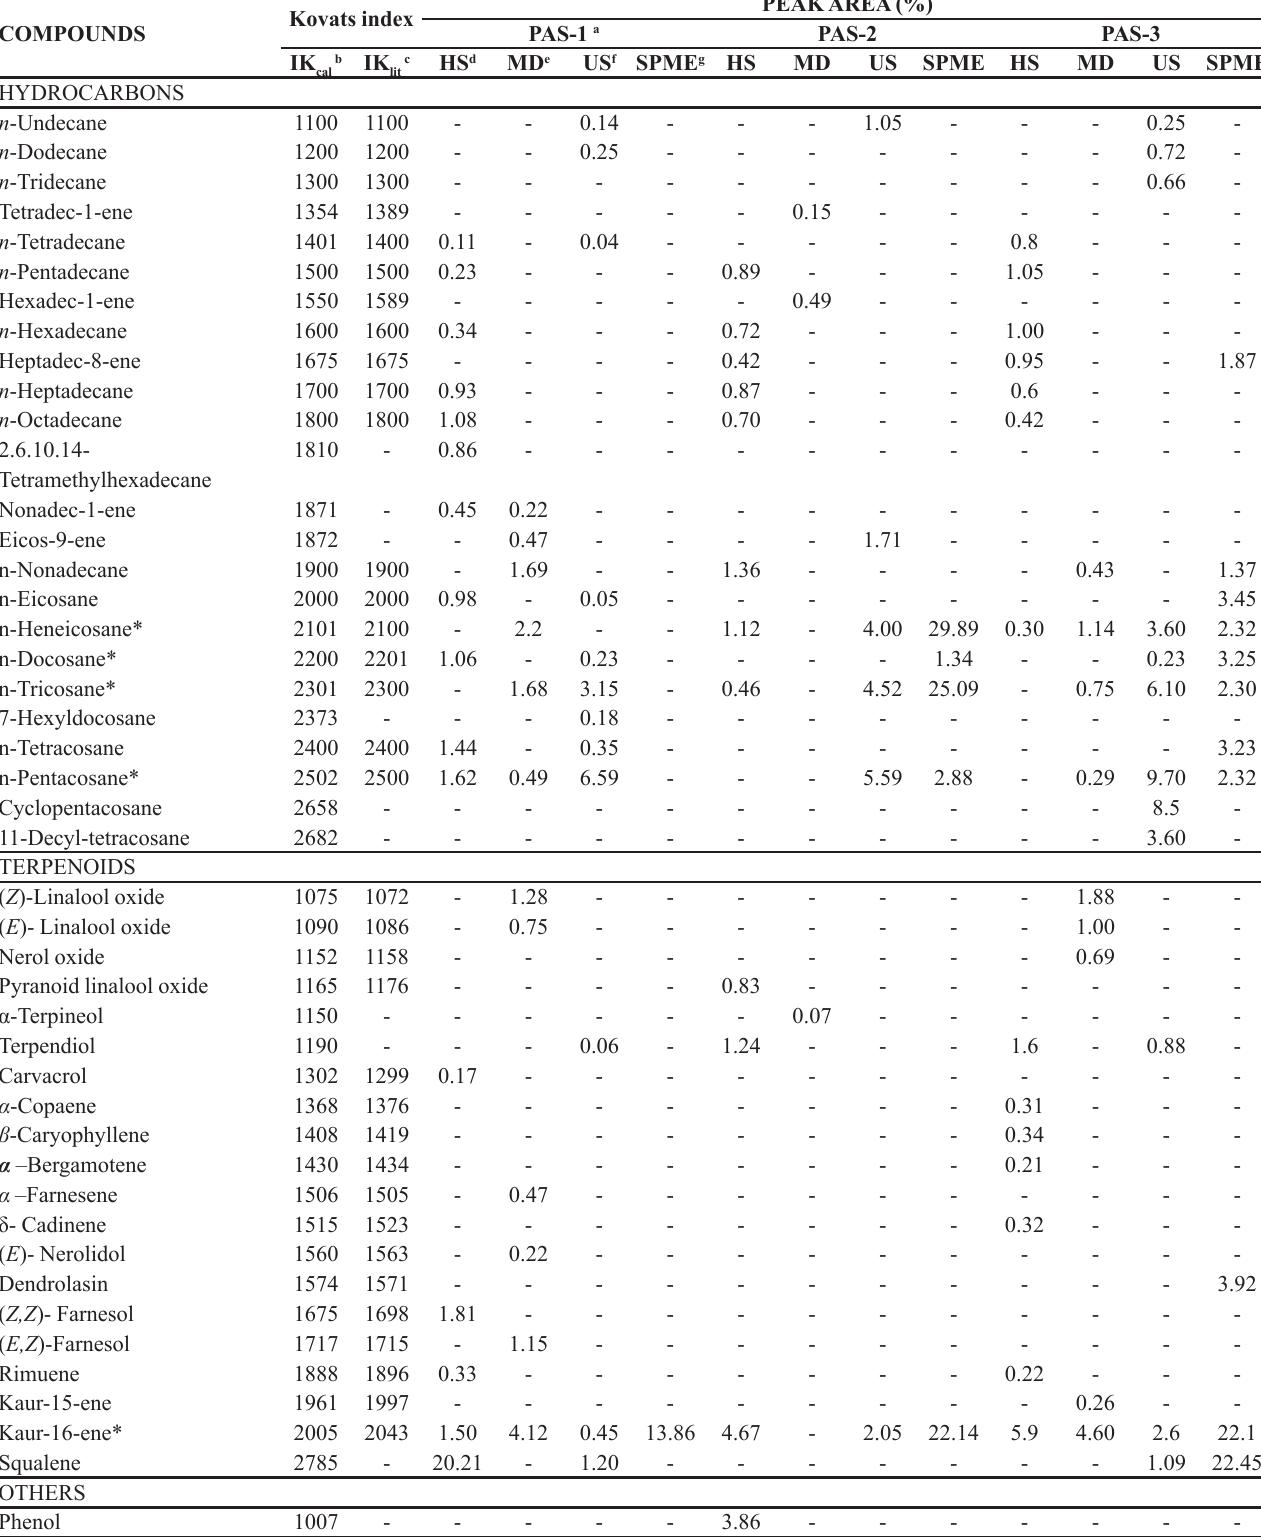
TABLE I - Chemical constituents of volatile stingless bee pollen collected in the months of December, March and July and extracted by HS, MD, US and SPME with their relative abundances